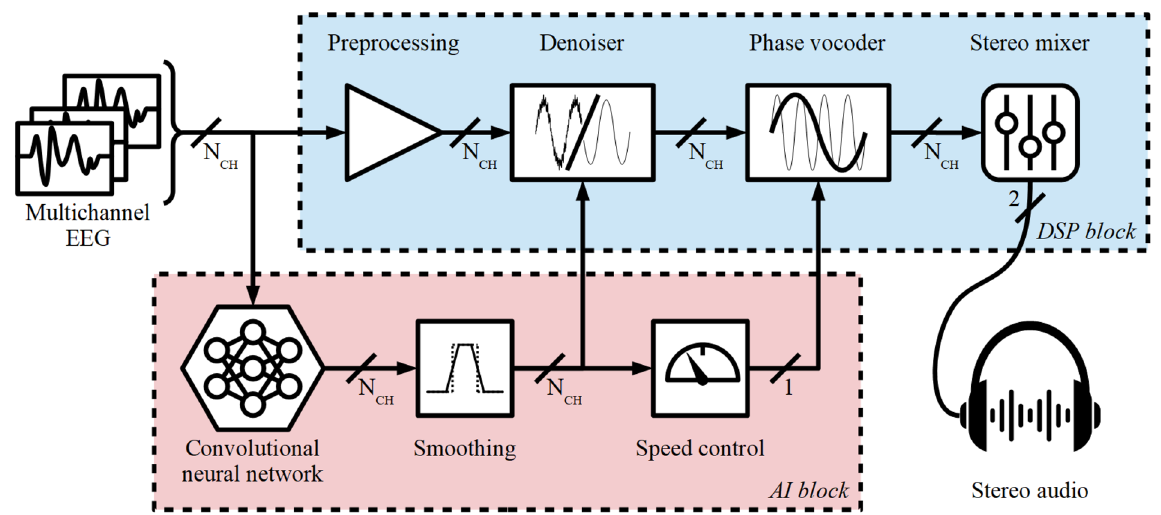
Figure 1. AI-driven sonification algorithm block